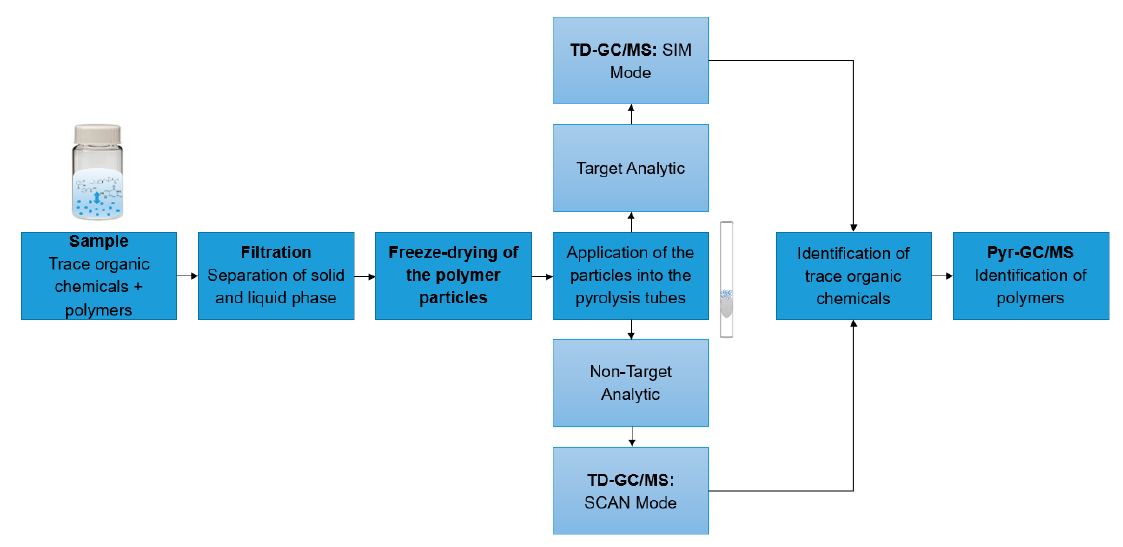
Figure 3. Workflow of sample analysis: First, the samples to be analyzed are filtered to separate the solid from the liquid phase. Then, the samples are applied into the pyrolysis tubes. Depending on the test setup, a non-target analytic (SCAN mode) or a target analytic (SIM mode) can be performed. Finally, a TD-Pyr-GC/MS analysis is conducted.